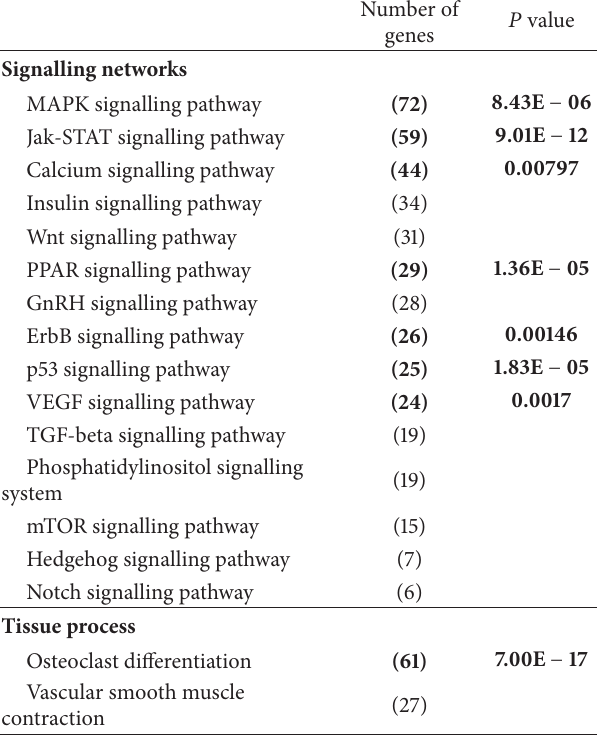
Table 2: Results of the KEGG pathway analysis of the T. gondii host/pathogen interactome: Signalling networks, Tissue and cellular process, metabolism and neuronal related pathways. The number of genes recovered in each pathway is in brackets and the enrichment 𝑃 value from the CPDB analysis, provided where available, and significant values highlighted in